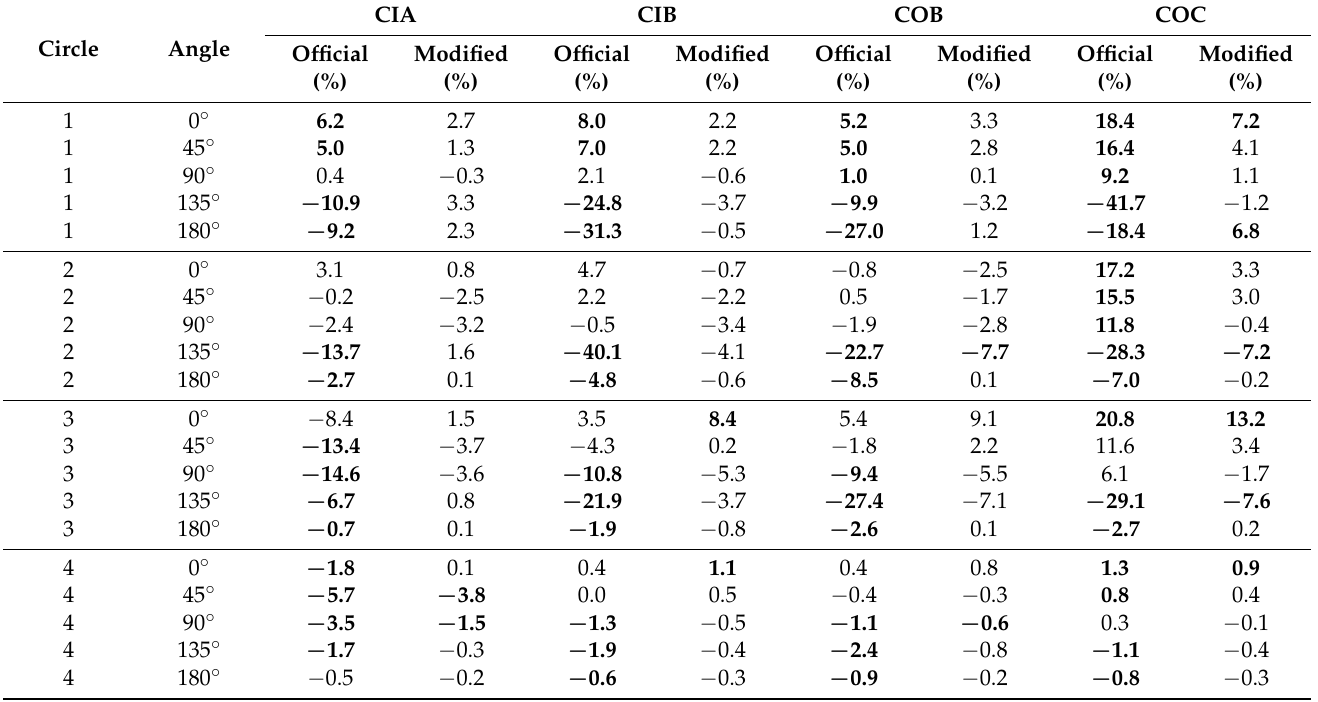
Table 4. Surface points dose differences, expressed as a percentage, between the reference data, reported in Table 1 and our MC calculations using the official and modified geometries. Difference values superior to the standard deviations reported in Table 1 are highlighted in bold.